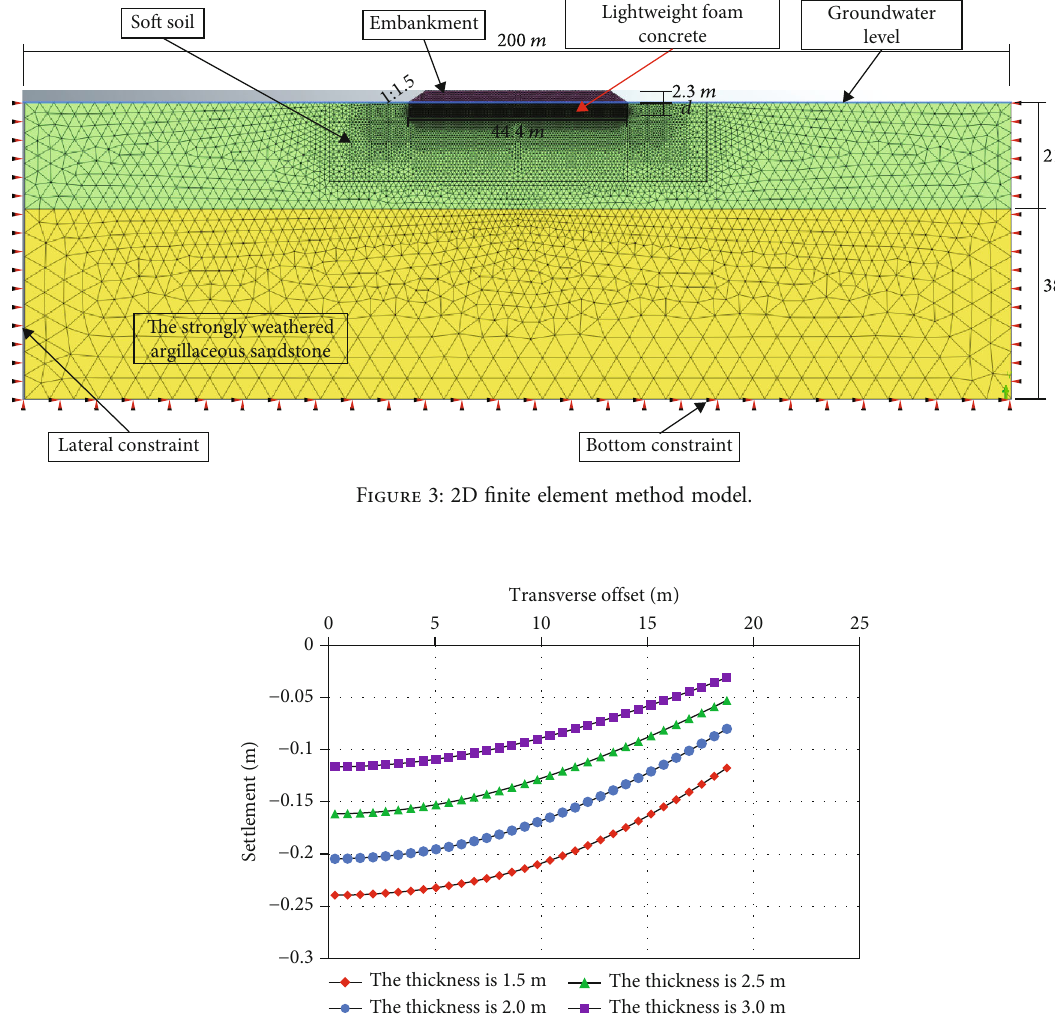
Figure 4: Settlement-transverse o ff set curves on the top of embankment with di ff erent thicknesses of